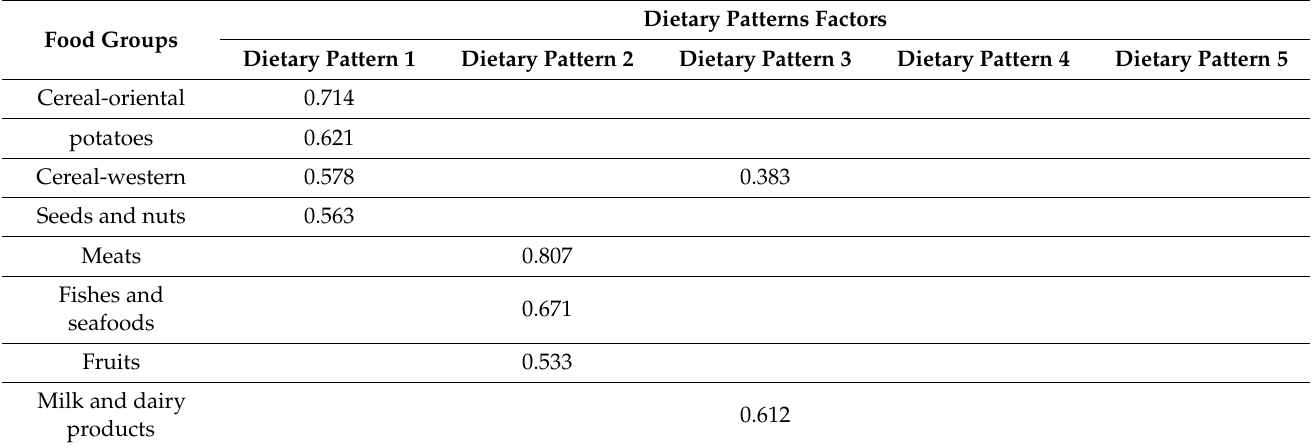
Table 2. Dietary patterns based on factor loading values by factor analysis of 17 food groups rotated component